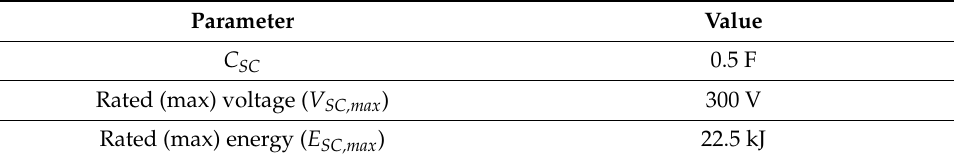
Table 3. The SCES system